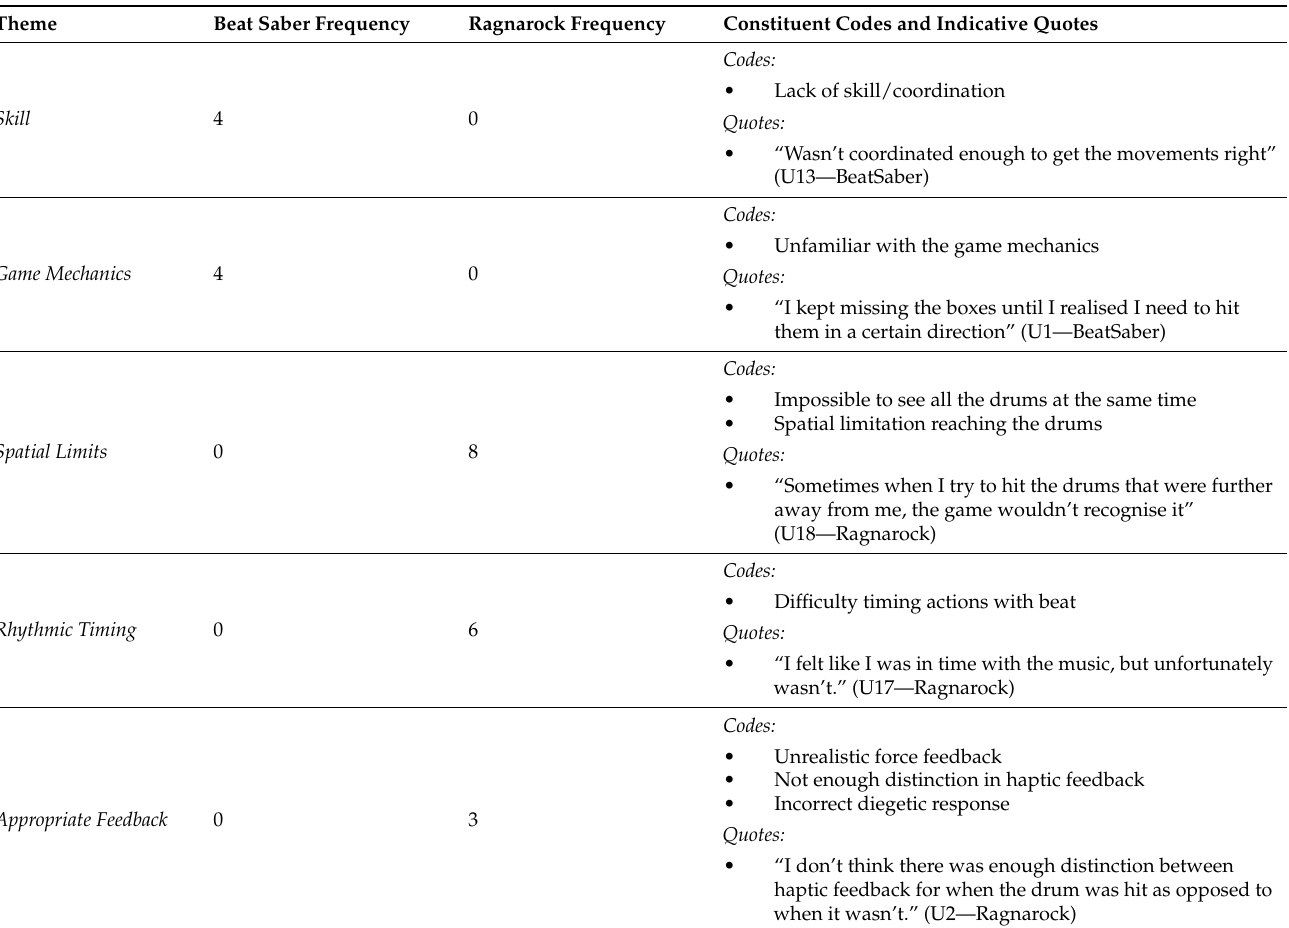
Table 5. Frequency of themes per game relating to users’ frustrations, with illustrative